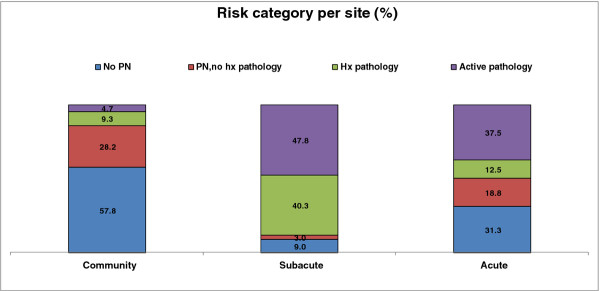
The proportion of patients seen at baseline at each site according to risk category.